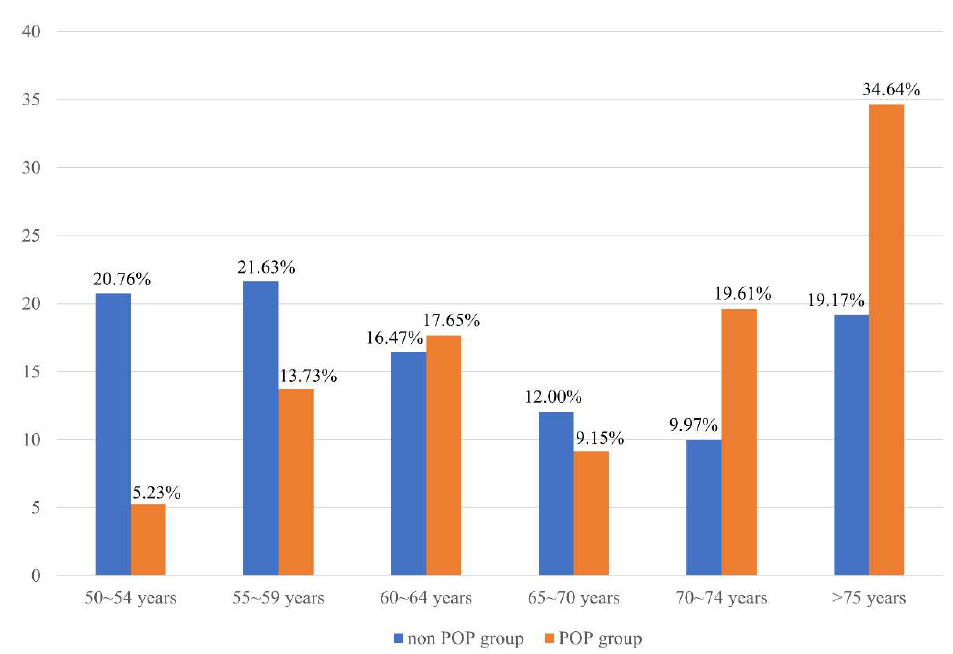
Figure 3. Increased prevalence of pelvic organ prolapse (POP) among women with osteoporosis ( p < 0.0001). (Figure 4) (Table 4).